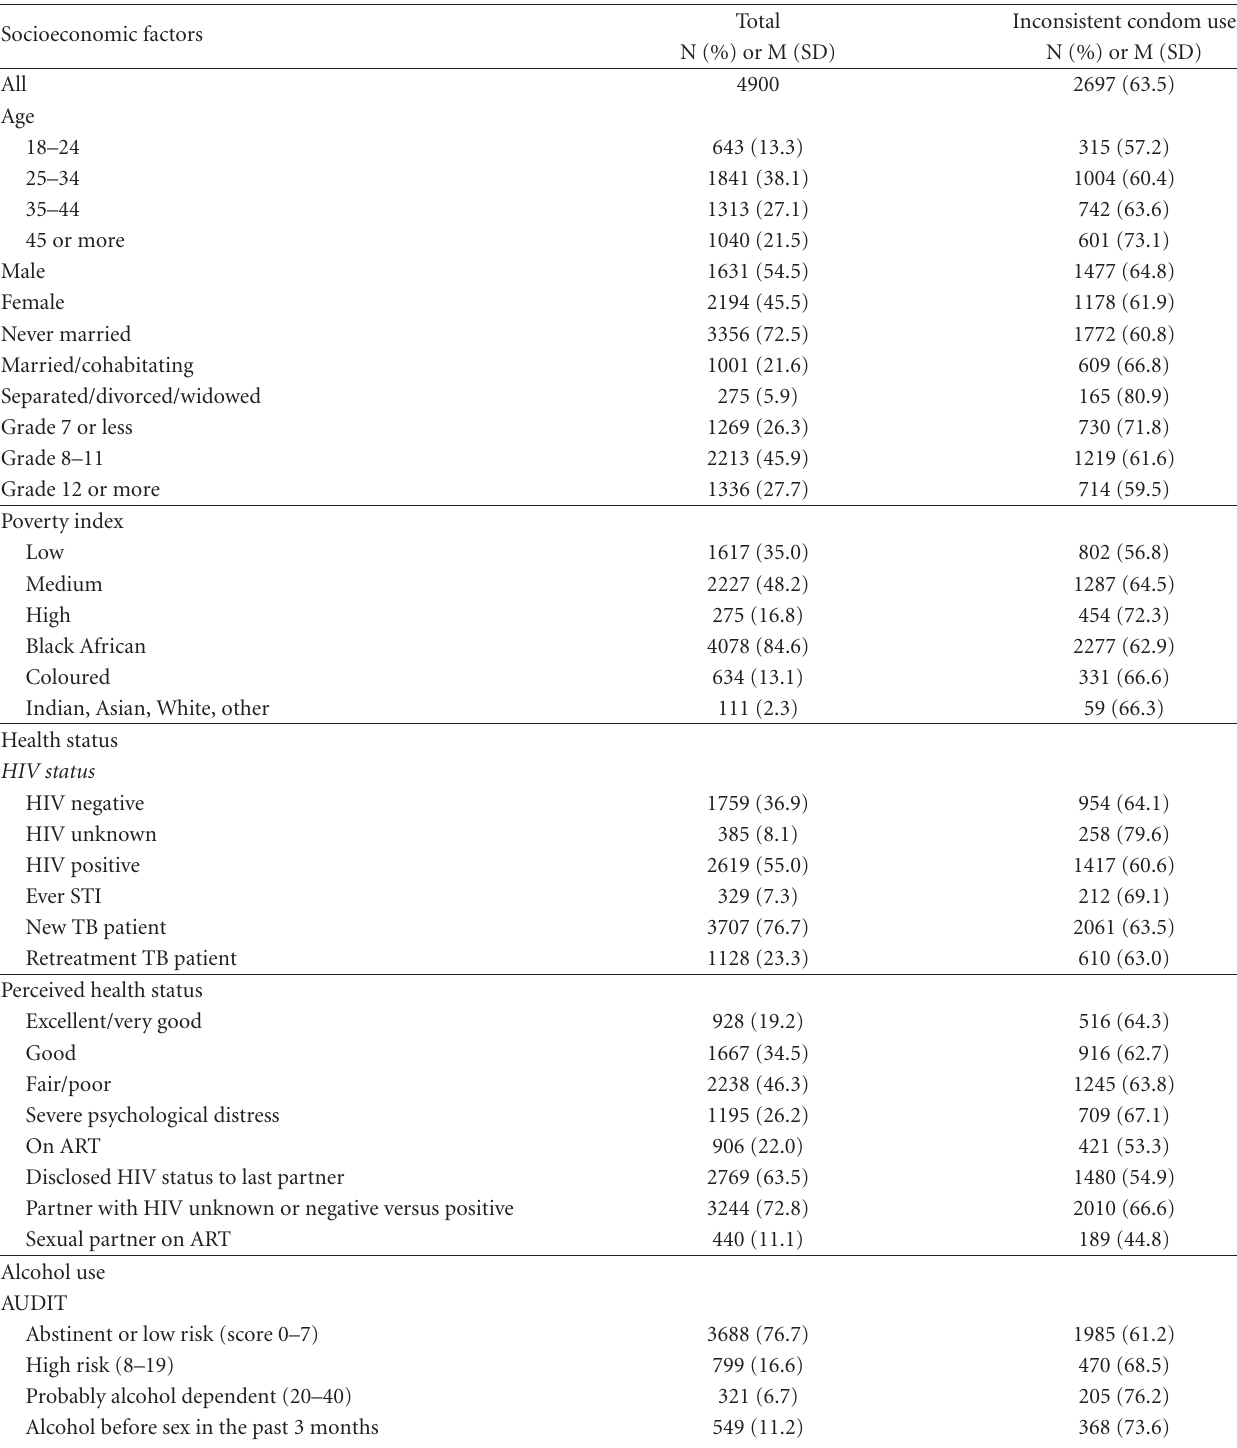
Table 1: Sample characteristics and inconsistent condom